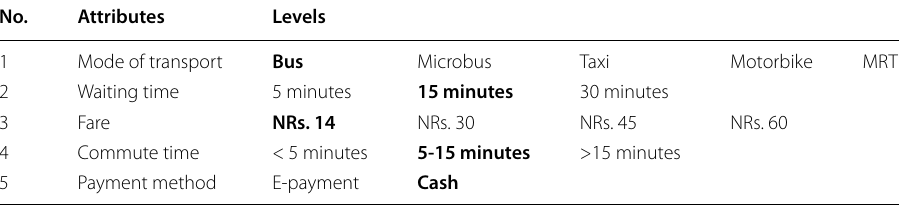
Bold and italics indicate the baseline. NRs represent Nepalese rupees